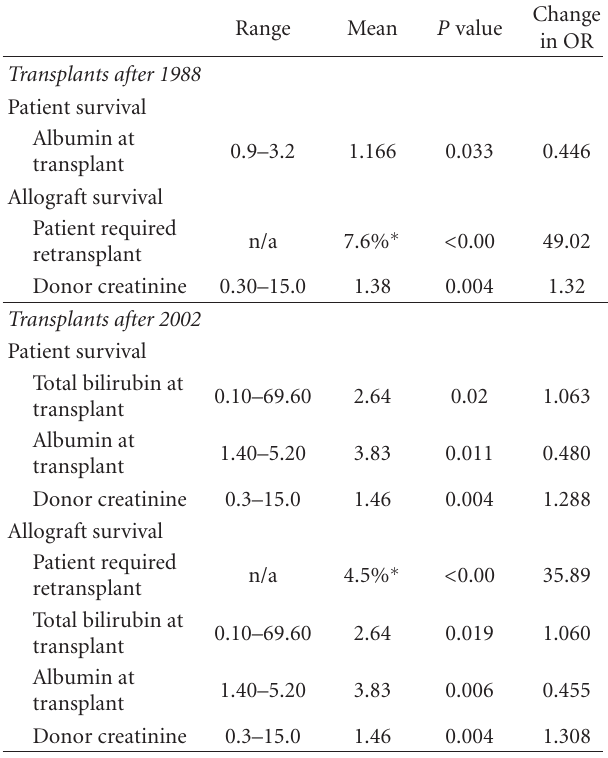
Table 1: Clinical Variables used for univariate analysis with signif- icance for patient and allograft survival. P values ≤ 0.2 were con- sidered significant for multivariate analysis and marked in bold for clarity.